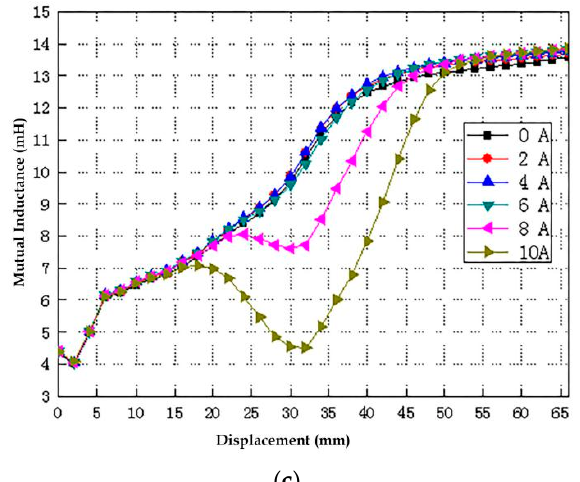
Figure 3. When the winding current is 0 A, 2 A, 4 A, 6 A, 8 A, 10 A, winding inductance and mutual inductance are shown in Figure 3. ( a ) Phase A self-inductance; ( b ) Phase A-B Mutual Inductance; ( c ) Phase A-C Mutual Inductance.